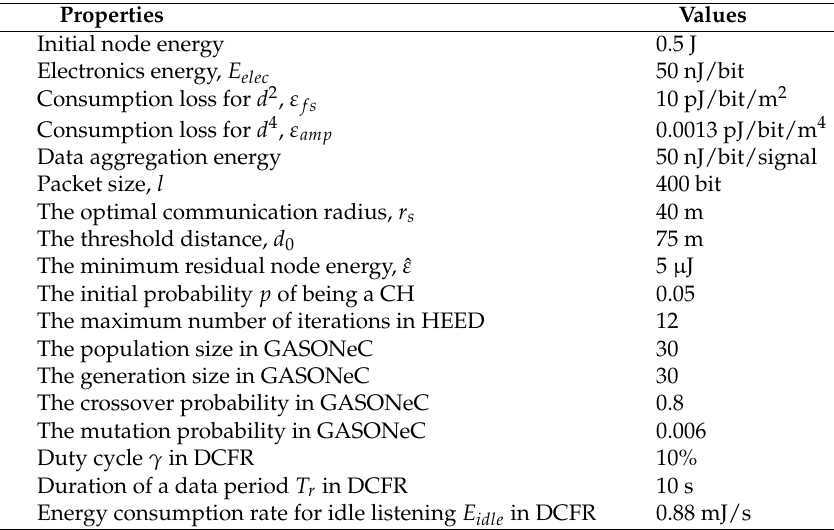
Table 1. The algorithms’ setting parameters.